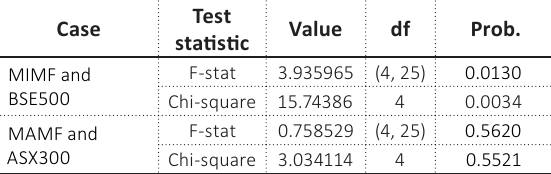
Table 10. Wald test results for MIMF and BSE500 and MAMF and ASX300 Source: Output extract from EViews software.